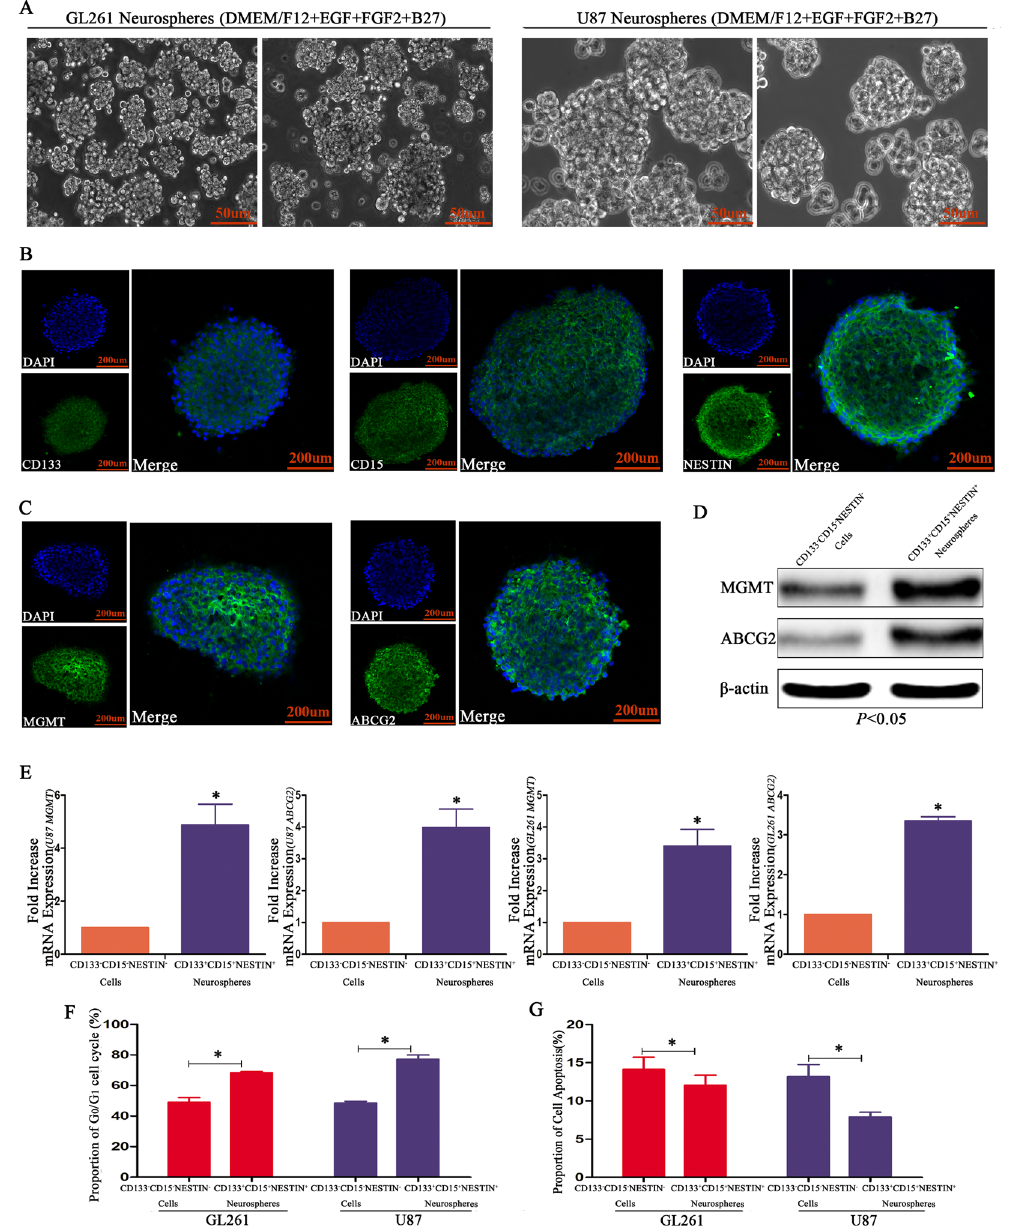
Figure 1. GSCs exhibited higher apoptosis rates than differentiated cells. ( A ) Sorted GL261 and U87 CD133 + / CD15 + /NESTIN + GSCs were cultured in stem cell medium, and these cells grew with a sphere morphology in suspension. ( B ) U87 neurospheres highly expressed CD133, CD15 and NESTIN. ( C,D ) There was an increased expression of ABCG2 and MGMT in U87 neurospheres. ( E ) Three to five-fold higher expression levels of ABCG2 and MGMT were observed for GL261 and U87 CD133 + /CD15 + /NESTIN + GSCs than CD133 − / CD15 − /NESTIN − cells ( * P < 0.05, Paired-samples T Test). ( F ) GL261 and U87 CD133 + /CD15 + /NESTIN + GSCs arrested the cell cycle in G 0 /G 1 ( * P < 0.05, Paired-samples T Test). ( G ) Higher apoptosis rates were observed for GL261 and U87 CD133 − /CD15 − /NESTIN − cells than for GSCs after TMZ (100 μ M) treatment ( * P < 0.05, Paired-samples T